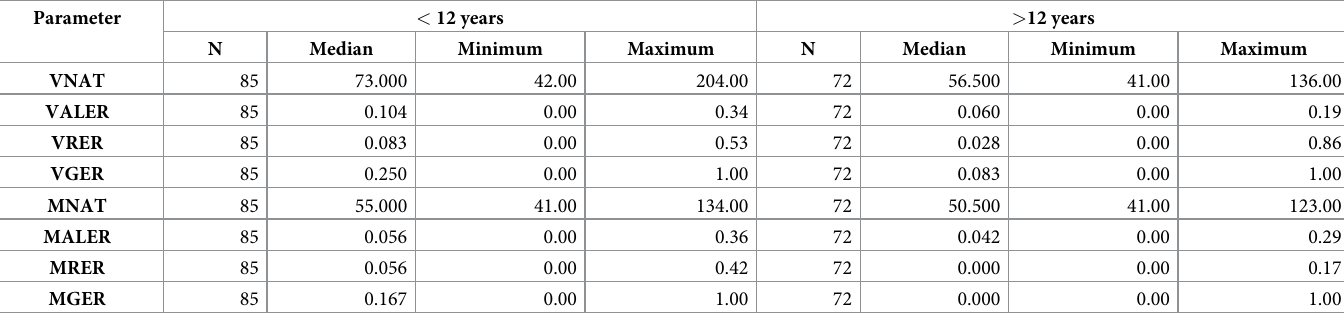
Table 3. Descriptive statistics of performance (NAT, ALER, RER, GER) in both paradigms (V: visual, M: multisensory) below and above 12 years of age. Parameter < 12 years > 12 years N